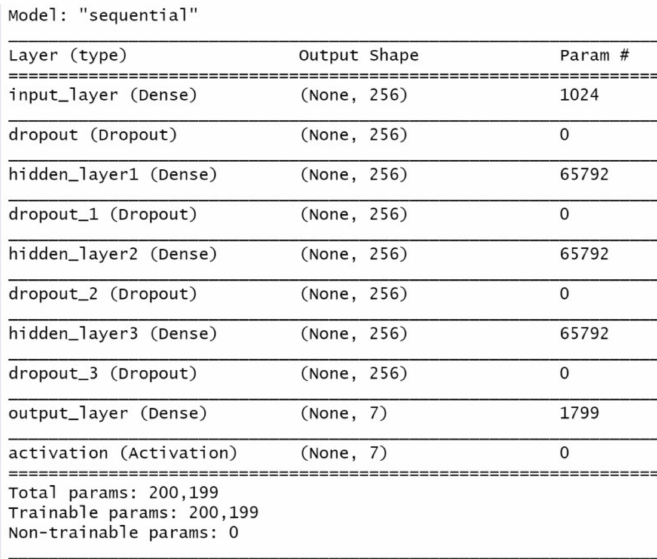
Figure 3. ( a ) Deep learning model using Tensorflow and Keras. ( b ) Compile the model. ( c ) Train the model. ( d ) Evaluate the model.